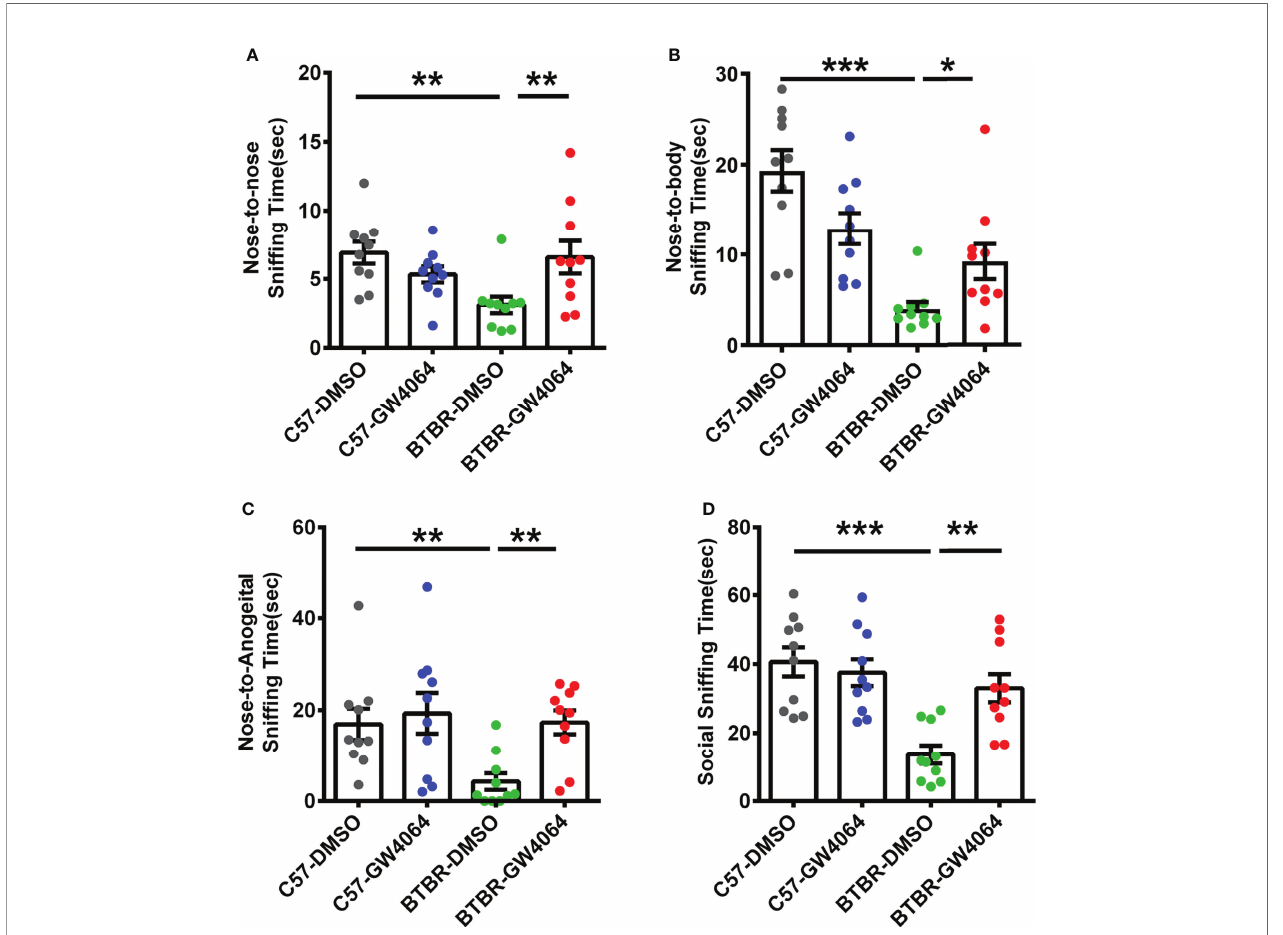
FIGURE 2 | GW4064 treatment rescued the de fi cits in male-female reciprocal social interactions of BTBR mice. (A – D) . BTBR mice showed a signi fi cant lower time in the nose-to-nose (A) , nose-to-body (B) , nose-to-anogenital (C) , social snif fi ng time (D) than the C57 mice. The treatment of GW4064 improved the impairments in BTBR mice. The data are presented as the mean ± SEM. n= 10. *p < 0.05, **p < 0.01, ***p <